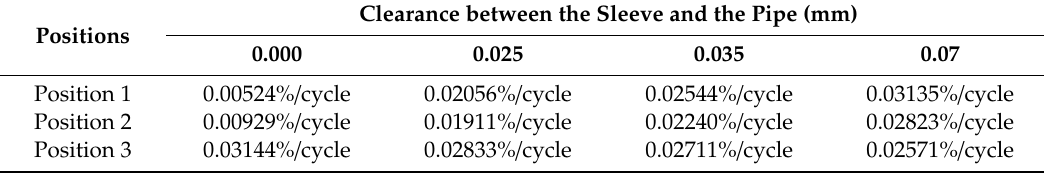
Table 3. The average hoop ratcheting strain rate at different positions for different clearance under internal pressure of 21 MPa.